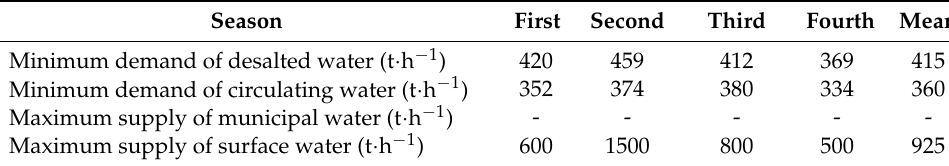
Table 2. Water demand and water source availability in different seasons.